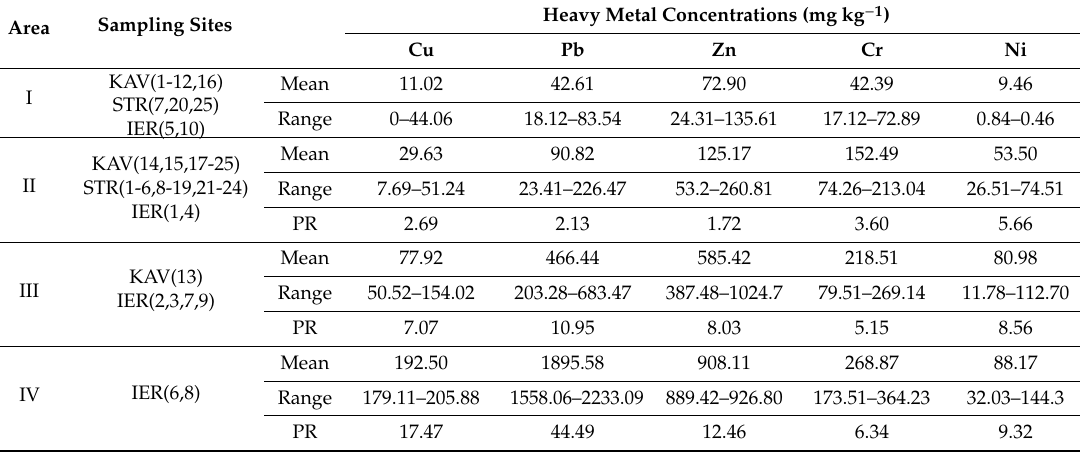
Table 3. Sampling sites and levels of heavy metals in various subareas of the study region.